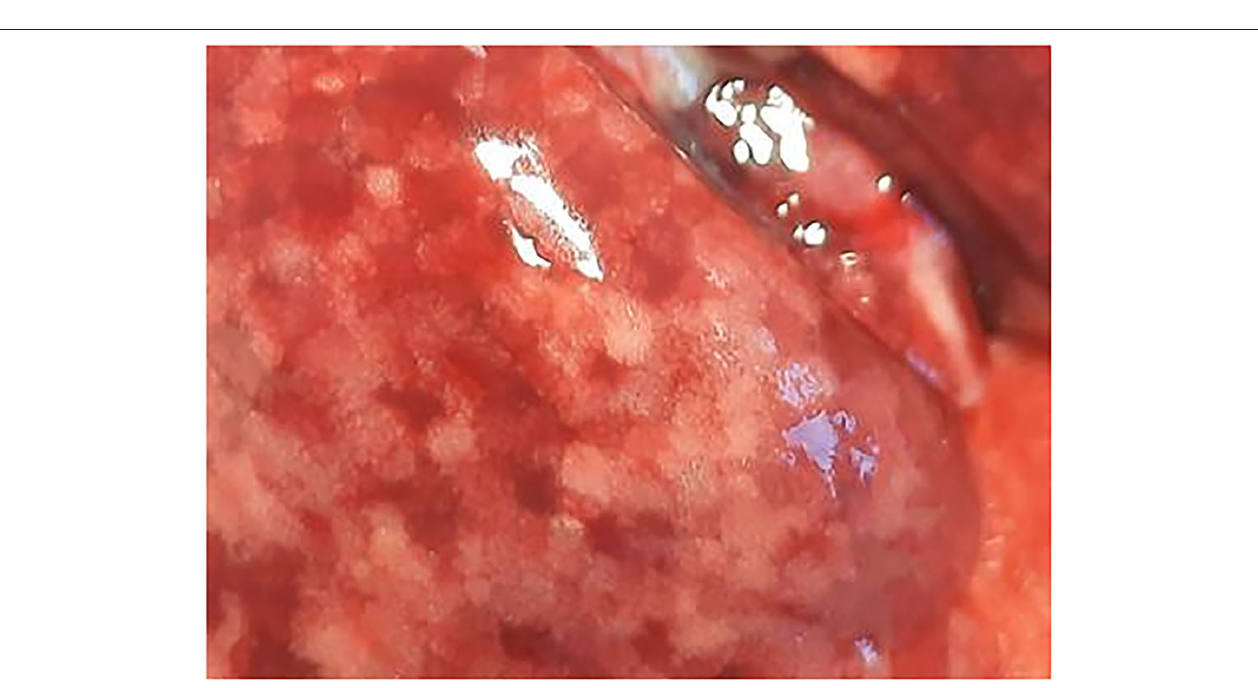
FIGURE 2 | Male rat. Deceased 1h. after inhalation (in cage). Marbled discoloration of lung surface due to congestion. Visible focal petechia. Whitish areas are representative of air-filled alveolar structures (indicative of acute emphysema).